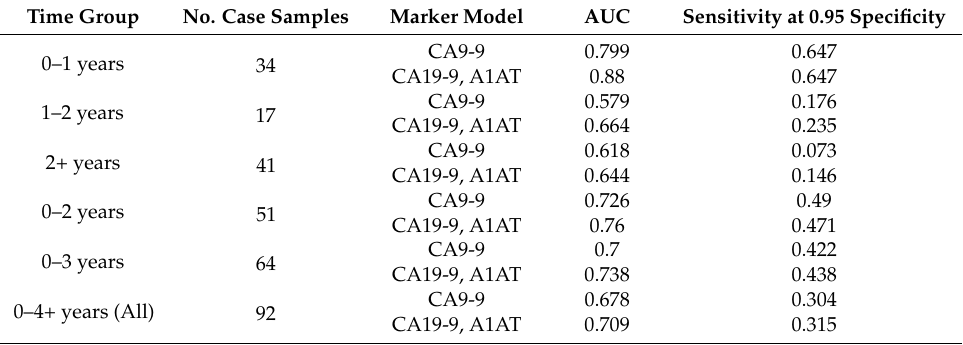
Figure 4. Testing α -1-antitrypsin (A1AT) as an early biomarker. Box and whisker plots showing A1AT ELISA data for individual case samples in different time groups prior to PDAC diagnosis and matched controls. Whiskers represent the 5th and 95th percentiles. The p values are shown for significant ( p < 0.05) differences. Table 3. Performance of logistic regression models comparing carbohydrate antigen 19-9 (CA19-9) alone and CA19-9 and A1AT in combination. The number of case samples is shown for each group. Data from all control samples ( n = 120) was used. The area under the receiver operating characteristics curve (AUC) and sensitivities are shown for both models for each time group at a fixed specificity of 0.95.